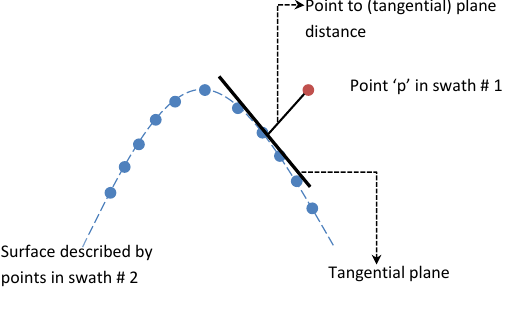
Figure 3 Representation of DQM over natural surfaces. Point ‘p’ (red dot) is from swath # 1 and the blue dots are from swath # 2